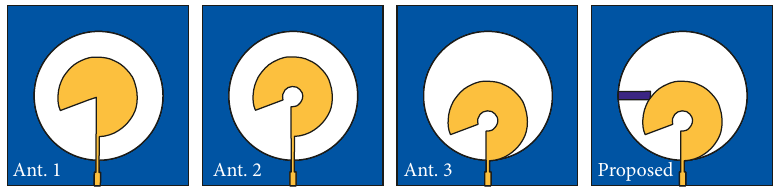
Figure 2: Four evolutionary models with different